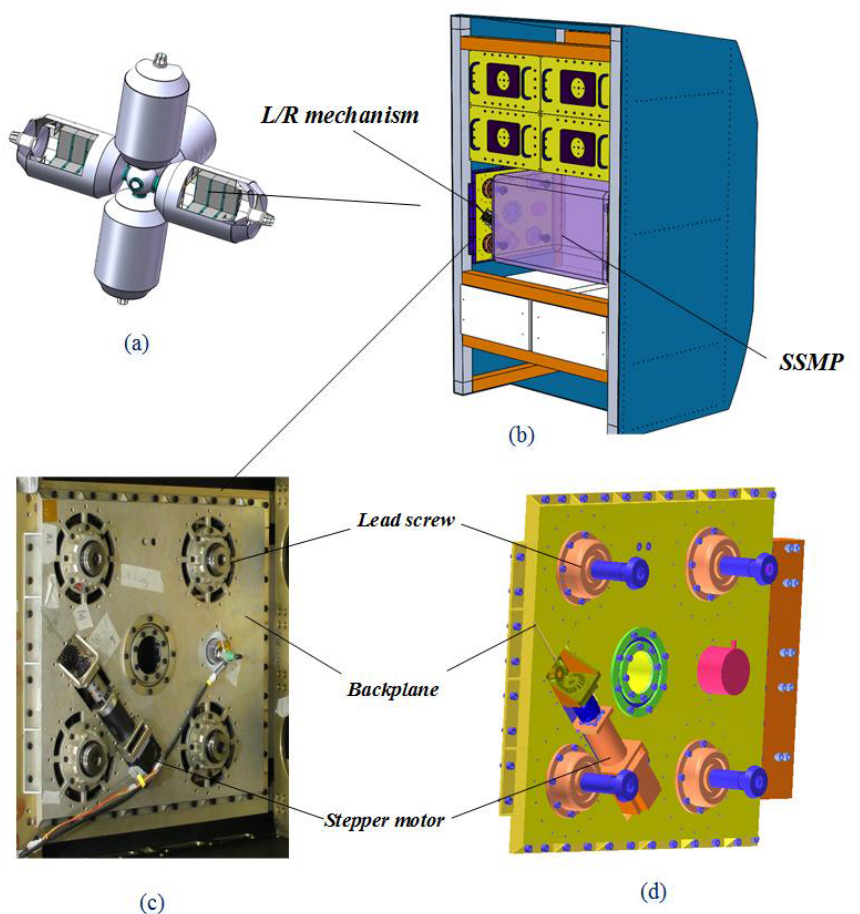
Figure 1. Hierarchical relation (a) conceptual model of the Chinese Space Station; (b) scientific research experimental rack and the SSMP with two L/R mechanisms in a locked status; (c) physical prototype and (d) 3-D model of the L/R mechanism on a side of the